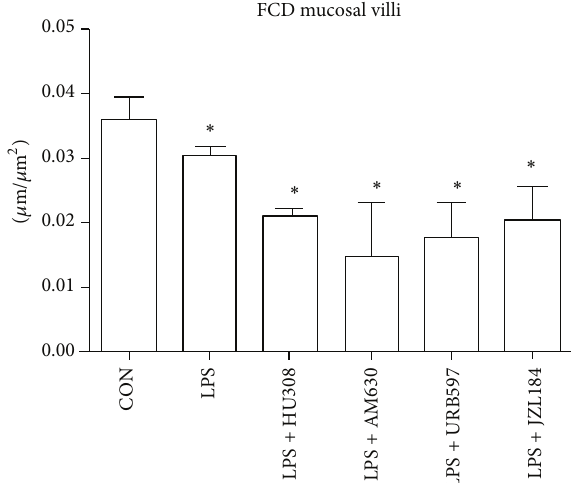
Figure 4: Functional capillary density (FCD) as a measure of capillary perfusion within mucosal villi. Calculated as total length of capillaries with erythrocyteperfusion within a predetermined rectangular field. Controlgroup (CON);endotoxemia group LPS (5mg/kg); LPS + HU308 (2.5 mg/kg), a CB 2 receptor agonist; LPS + AM630 (2.5mg/kg), a CB 2 receptor antagonist/inverse agonist; LPS + URB597 (0.6mg/kg), a FAAH inhibitor; LPS + JZL184 (16mg/kg), a MAGL inhibitor. In every animal six mucosal regions were analyzed ( 𝑛 = 3 –5 mice/group). Data presented as mean ± standard deviation. ∗ 𝑃 < 0.05 versus